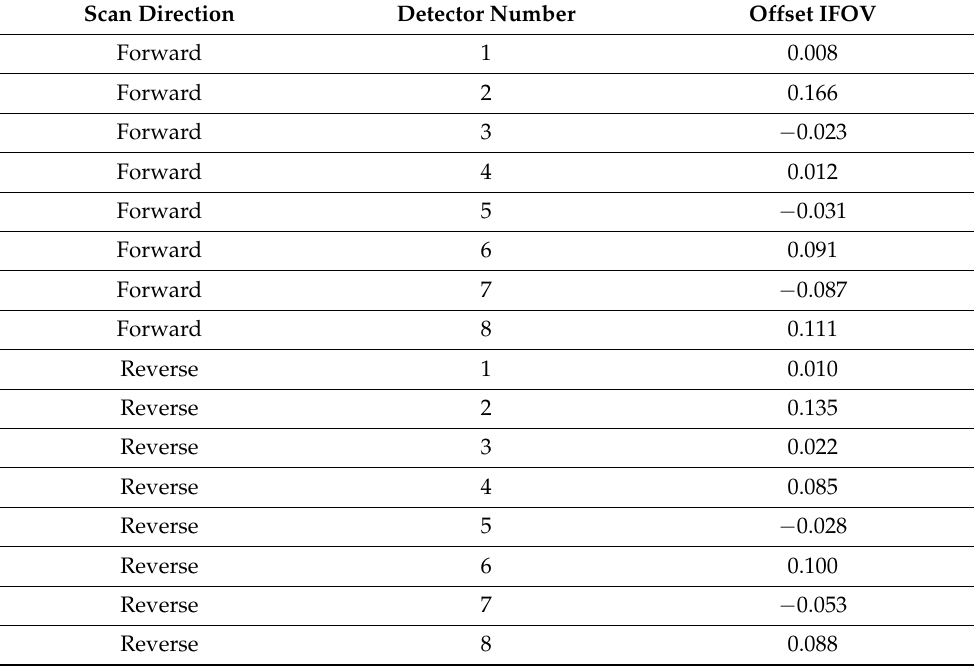
Figure 4. Thermal band detector displacements for the ETM+ for Collection 1 products. The results for the Landsat scene ID LE70390372003116EDC00 are shown in the plot. Measured offsets are shown. Individual measurements are displayed using green triangles, while the mean of those measurements is shown with red squares. Forward and reverse scan values for each detector are shown. Values are given concerning a thermal band detector Instantaneous Field of View (IFOV) and are prior to calibration. Table 1. ETM+ thermal band detector misalignment displacements for Collection 1 products for the Landsat scene ID LE70390372003116EDC00. Measured mean offsets are shown within the table for each detector for forward and reverse scans. Values are given concerning a thermal band detector (60 m) IFOV.